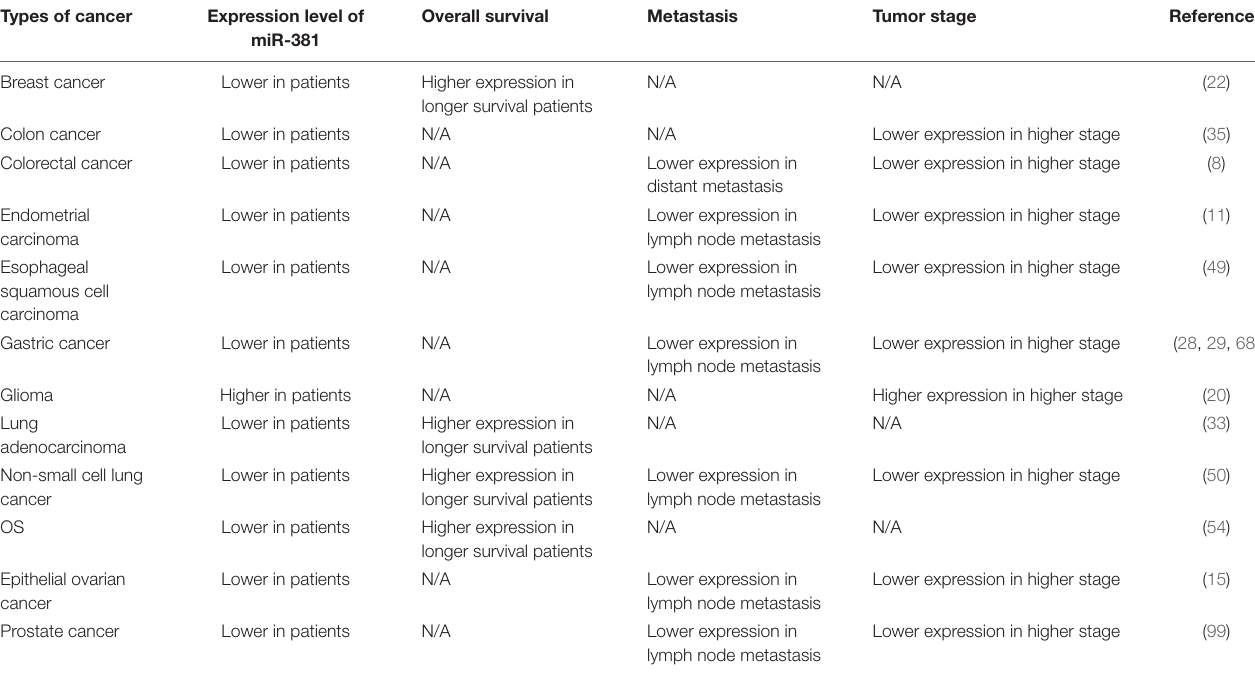
TABLE 4 | The relationship between miR-381 and various types of cancers’